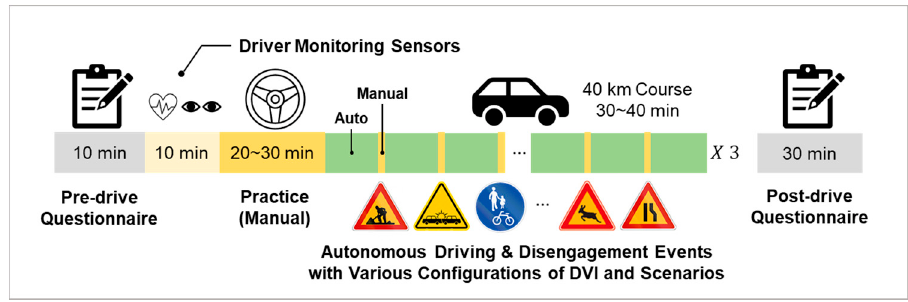
Figure 8. Schematic of the timeline of the experiments.